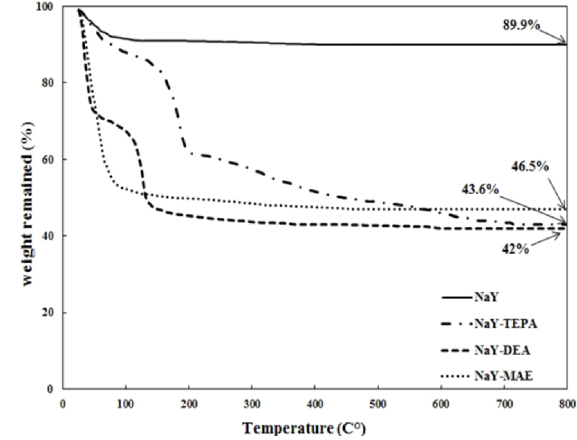
Fig. 4. TGA curves of NaY and amine-modified NaY